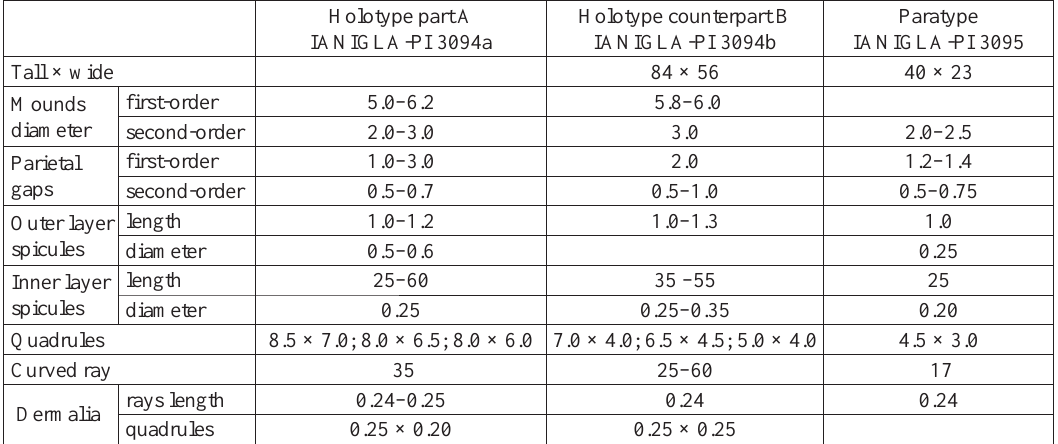
Table 2. Measurements (in mm) of spicules of Valospongia sonorensis sp. nov., at Cerro El Mogallón, Sonora,